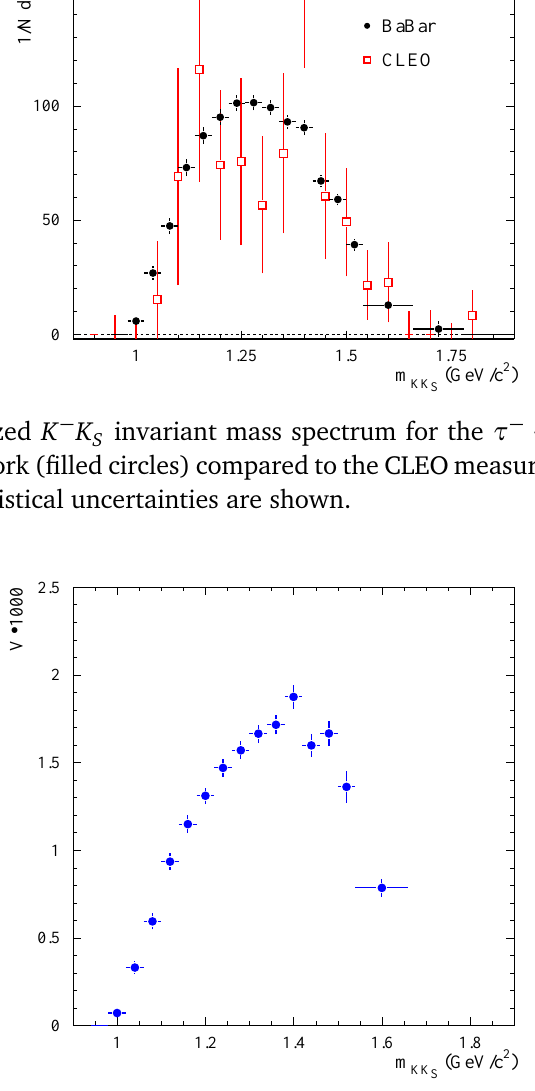
Figure 6: Measured spectral function for the τ − → K − K uncertainties are